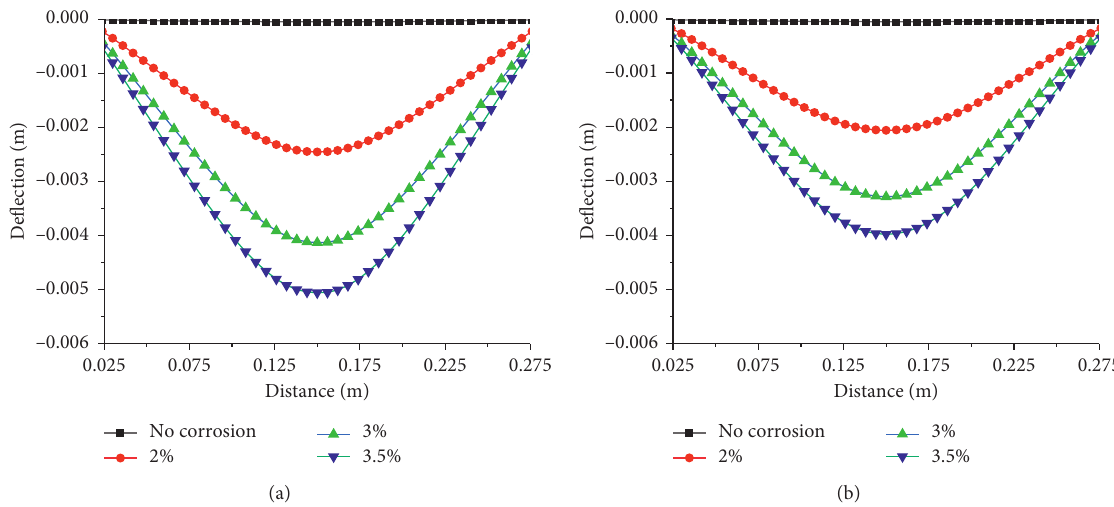
Figure 14: Deflection of the RC beam with different aggregate contents under different corrosion expansion pressures: (a) 25% and (b)